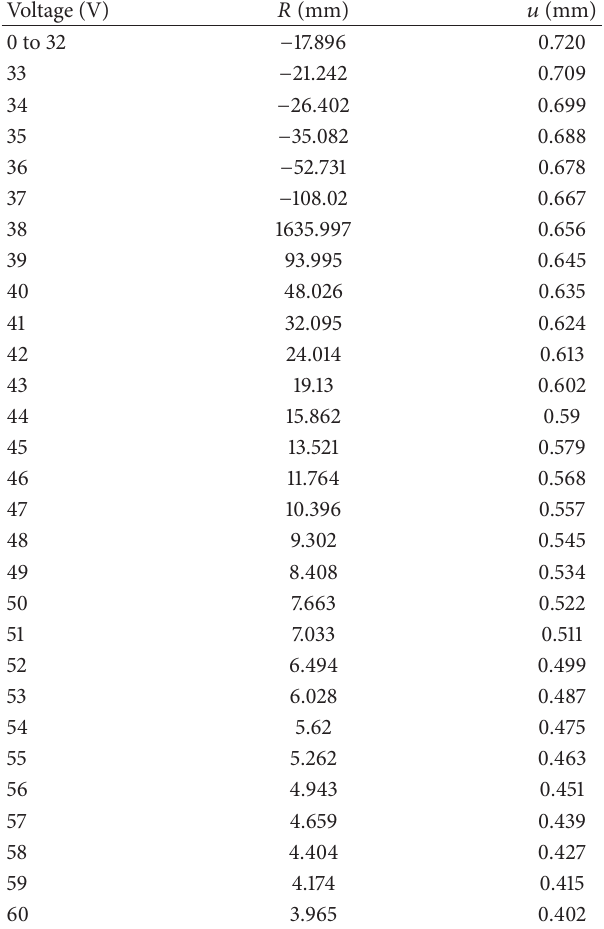
Table 3: The relation between the surface curvature, thickness, and driving voltage